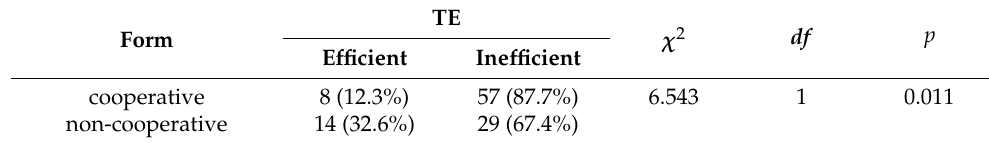
Table 4. Sample structure according to TE scores (authors’ calculations based on [77]).